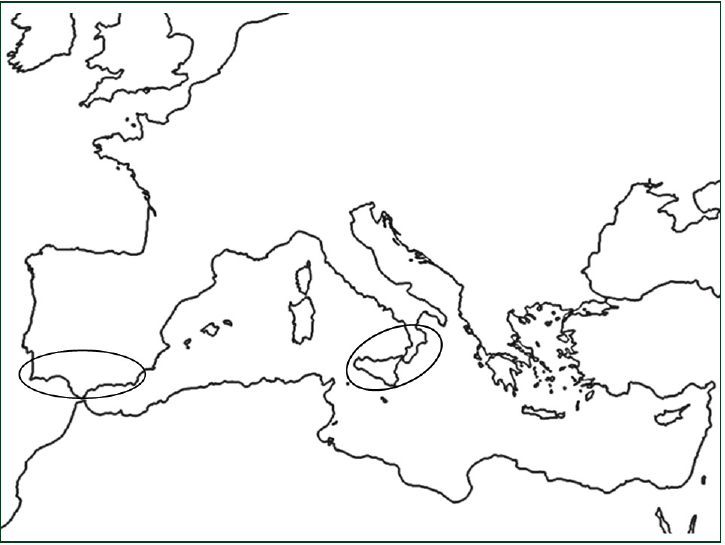
Figure 1. Sampling